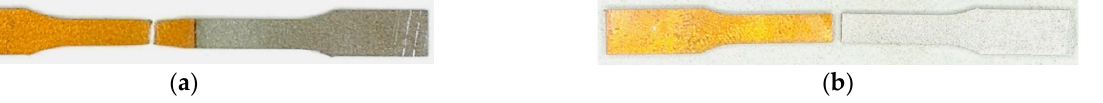
Figure 11. Fractured tensile test specimen joined using sheared surface: ( a ) Fracture at base metal of copper C1100; ( b ) Fracture at joint boundary.